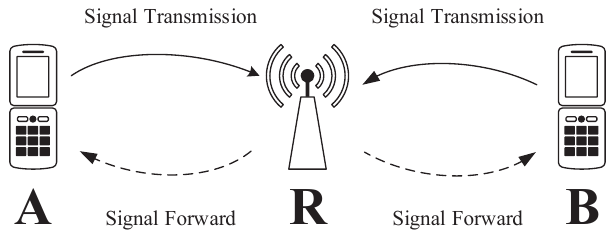
Figure 1. An OFDM two-way system with an untrusted relay. Solid lines: signal transmission on subcarriers in the first slot. Dashed lines: signal forward transmission on subcarriers in the second